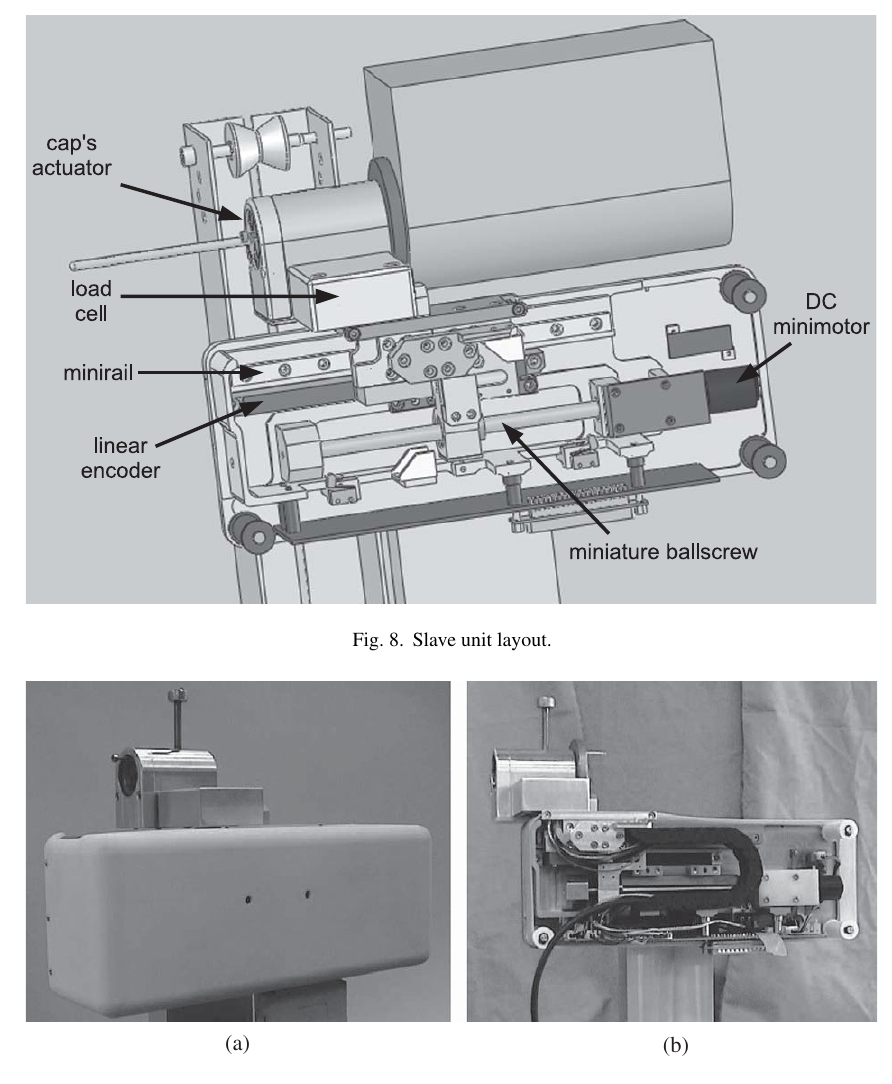
Fig. 9. DAANS slave unit. a) Slave unit. b) Slave